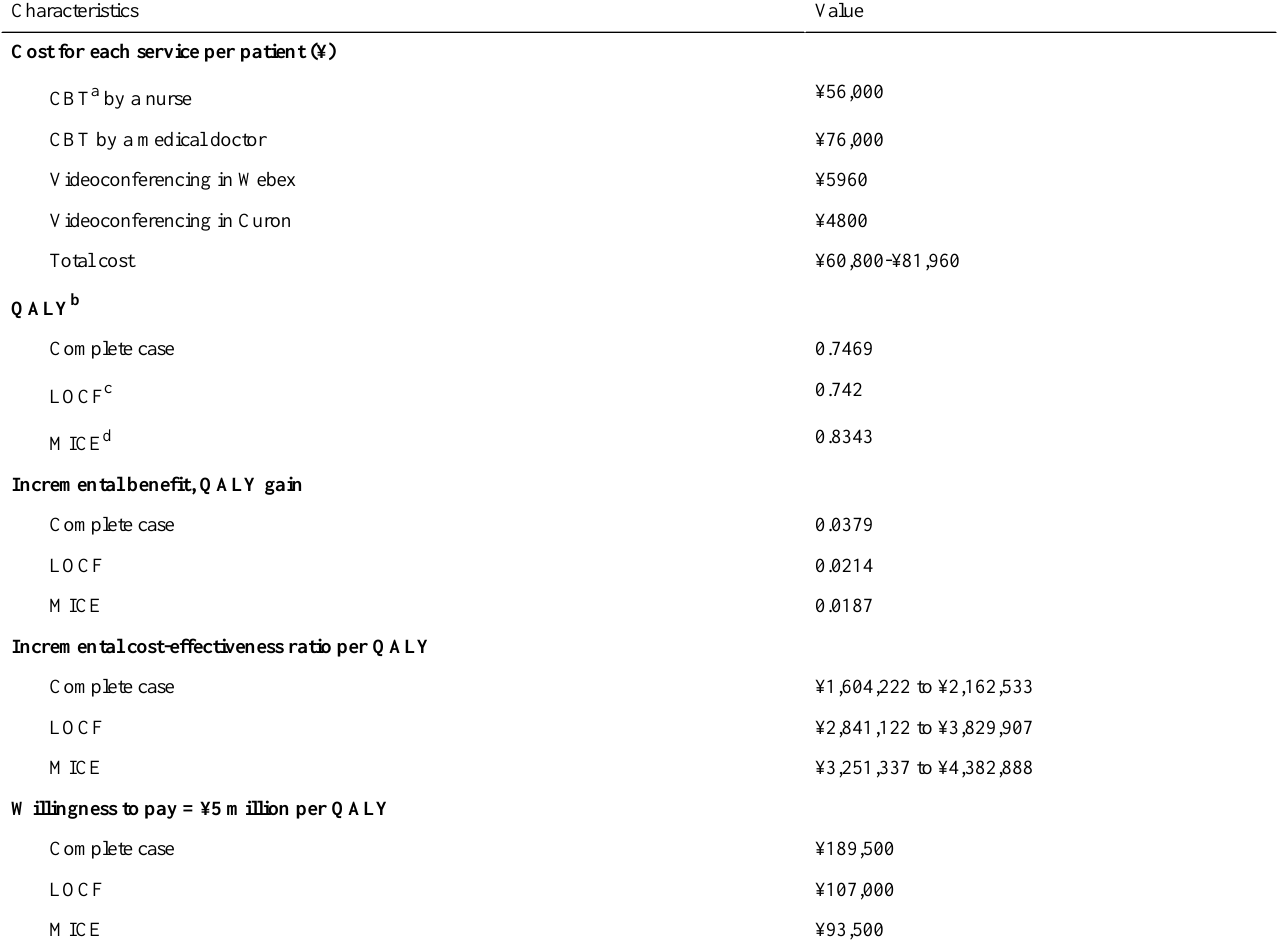
Table 7. Results of a cost-utility analysis.